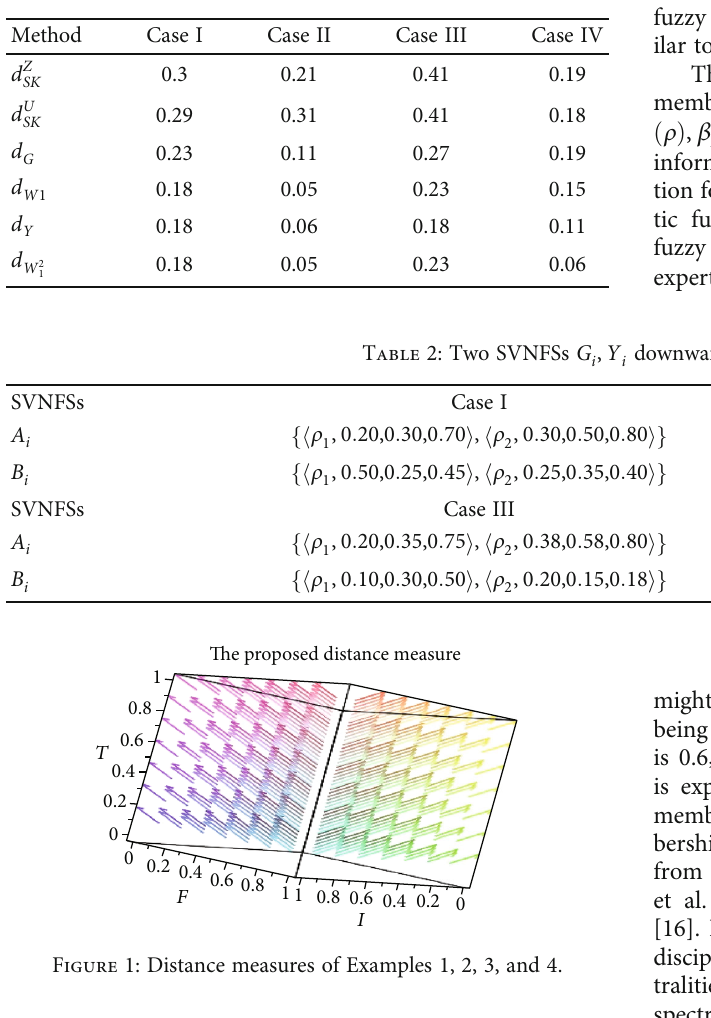
Table 1: Comparison of di ff erent distance measure downward case ð i = 1, 2, 3, 4 Þ .